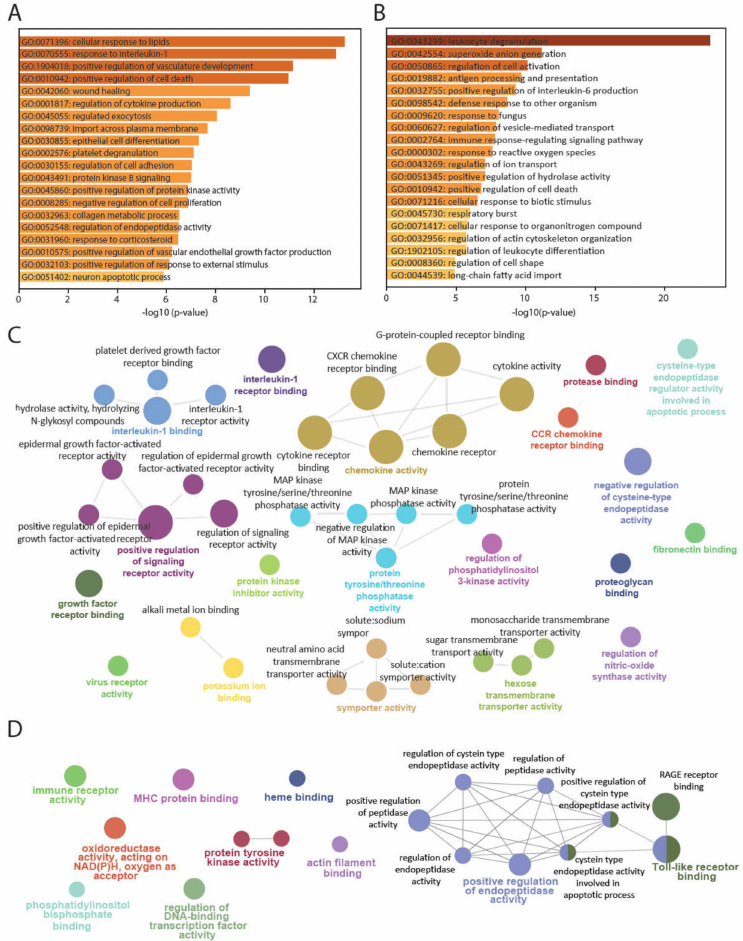
Figure 3. Tissue-regenerative pathways are upregulated in monocytes treated with PBMCsec Gene ontology pathway analysis was performed in Metascape. The top 20 biological processes affected by the upregulated ( A ) and downregulated ( B ) DEG in monocytes treated with PBMCsec are listed and hierarchically sorted by − log 10 ( p -value) and enrichment factor (>2). ( C ) ClueGO visualization of molecular functions associated with upregulated and ( D ) downregulated genes in monocytes treated with